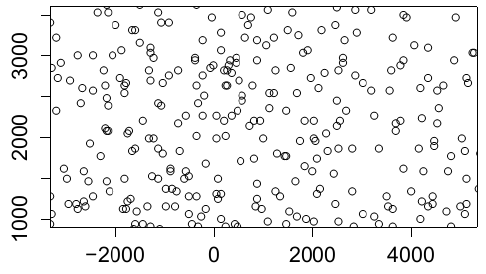
Figure 4. Real data locations of base stations, antennas of the mobile network in Paris